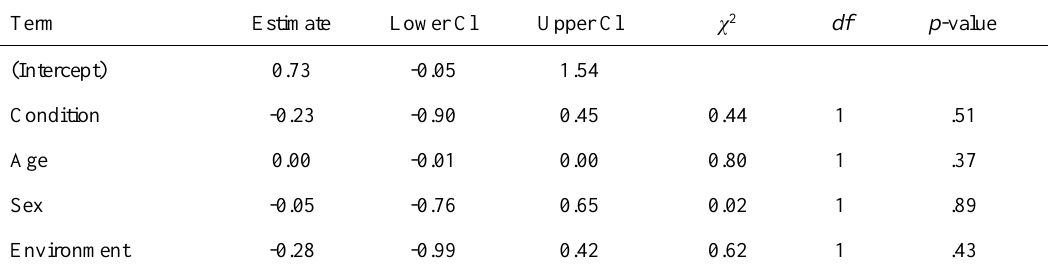
choices for the